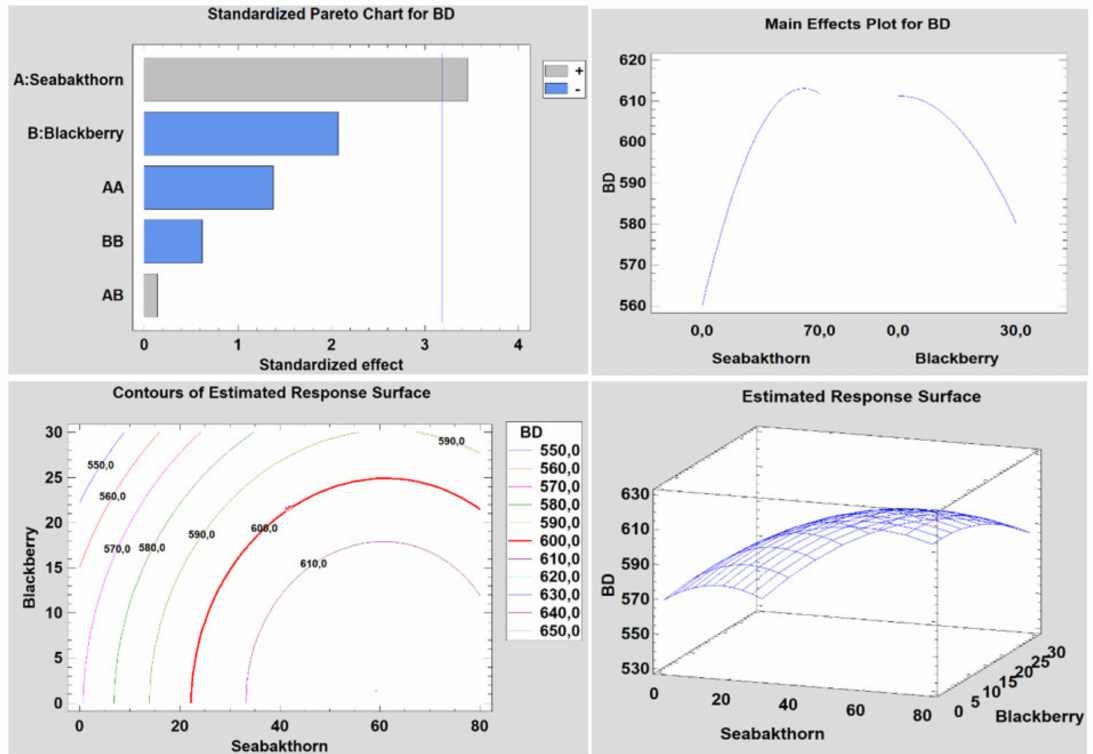
Figure 4. Graphical representation of the dependence of the bulk density of the pellets according to the percentage of the constituents of the raw material (seabuckthorn biomass + blackberry +